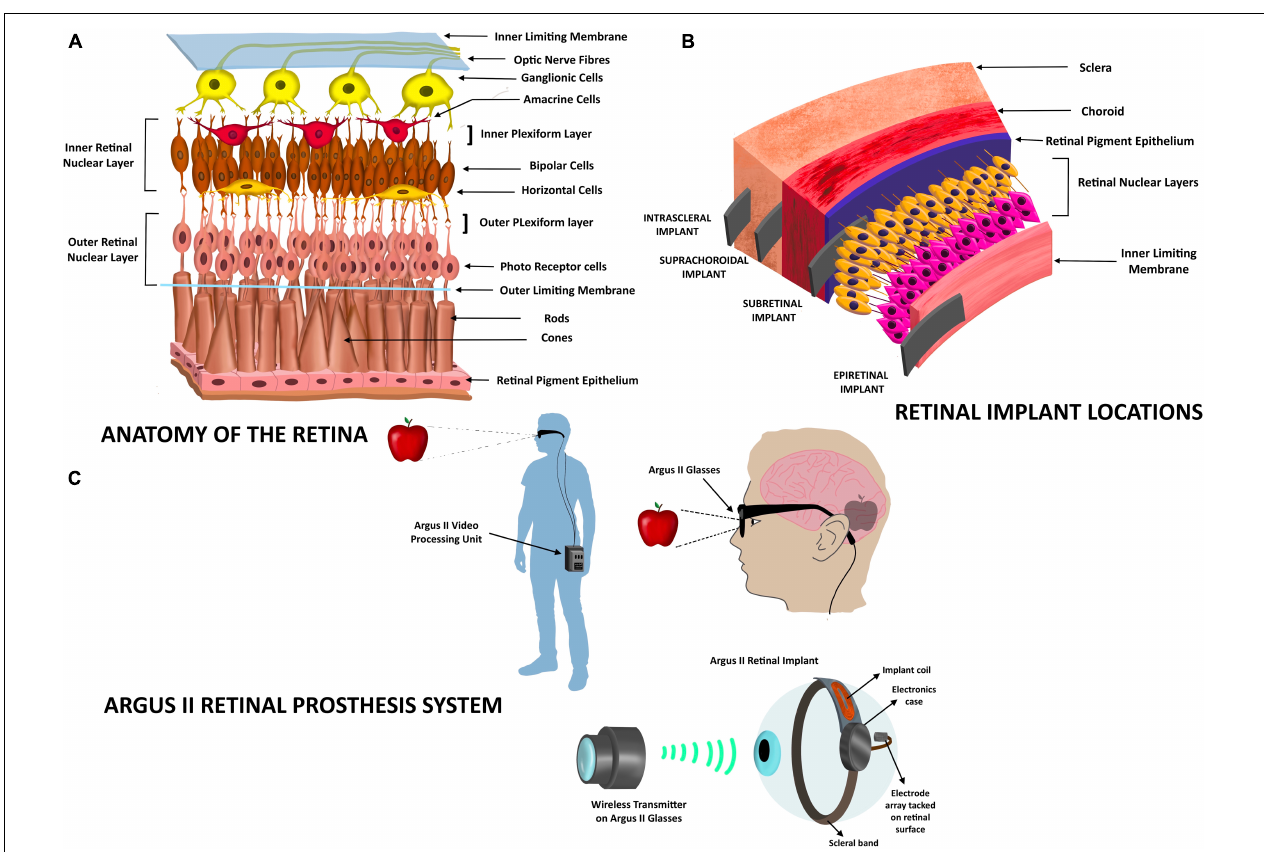
FIGURE 1 | Retinal implants. (A) Anatomy of the retinal layer. The figure depicts the organization of the retinal neural layer. The outer nuclear layer comprises nuclei of photoreceptor cells, while the inner nuclear layer consists of the nuclei of the Müllerian glia (not shown here), the bipolar cells, the amacrine and the horizontal cells. The photoreceptor cells synapse with the bipolar cells and horizontal cells. The bipolar and amacrine cells in turn synapse with the ganglionic cells whose axons form the optic nerve fiber. (B) Retinal implant locations. The types of retinal implants are represented according to their location in the eye: retinal, subretinal, suprachoroidal, and intrascleral. (C) Depiction of the Argus II Retinal Prosthesis system. The video/image (here shown as an apple) is captured by a camera on the glasses and is sent into an external portable processing unit that converts visual data received into electrical data. These data are sent back to the glasses that also contain a transmitter that wirelessly transmits the electrical message to the electrode array that is part of the retinal implant. The electrodes transform the information into electric impulses, which stimulate the retina and bring about transmission via the optic nerve to the visual cortex of the brain that perceives the